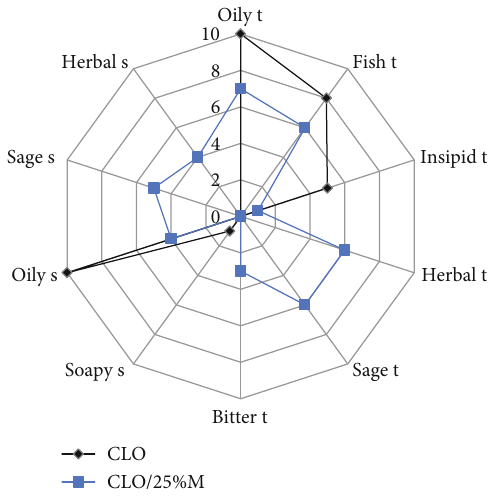
Figure 5: Taste (t) and smell (s) pro fi le of fi sh oil with 25% sage macerate (CLO/25%M) in comparison to raw fi sh oil